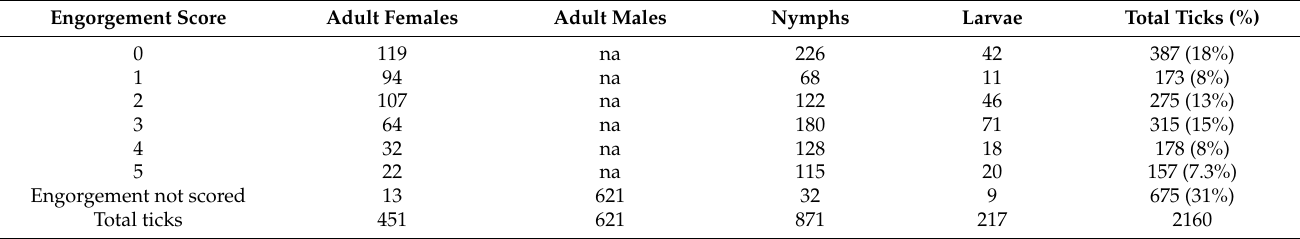
Table 4. Summary of attached ticks by life stage and engorgement status. Male ticks were unfed and not scored for engorgement. Additionally, some damaged ticks were not scored for engorgement. na = not